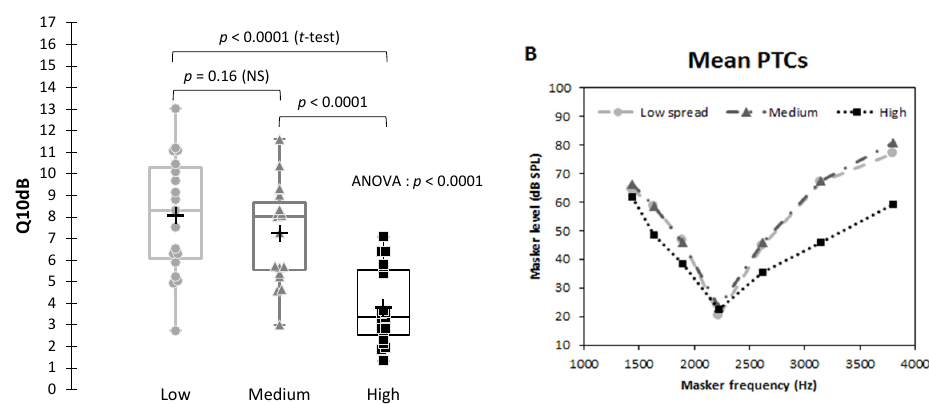
Figure 5. Comparison of the sharpness (Q10dB) of the average psychophysical tuning curves (PTC) function of the level of spread of excitation. Results of the repeated measure ANOVA and results of the 2-by-2 comparisons (Student’s t -tests). ( A ) Boxplots showing Q10dB: the horizontal line within the box indicates the median; means are indicated by a plus sign; edges are the 25th and 75th percentiles, whiskers the most extreme data points. Each dot represents one subject. ( B ) Average tuning curves for the three levels of spread of excitation.